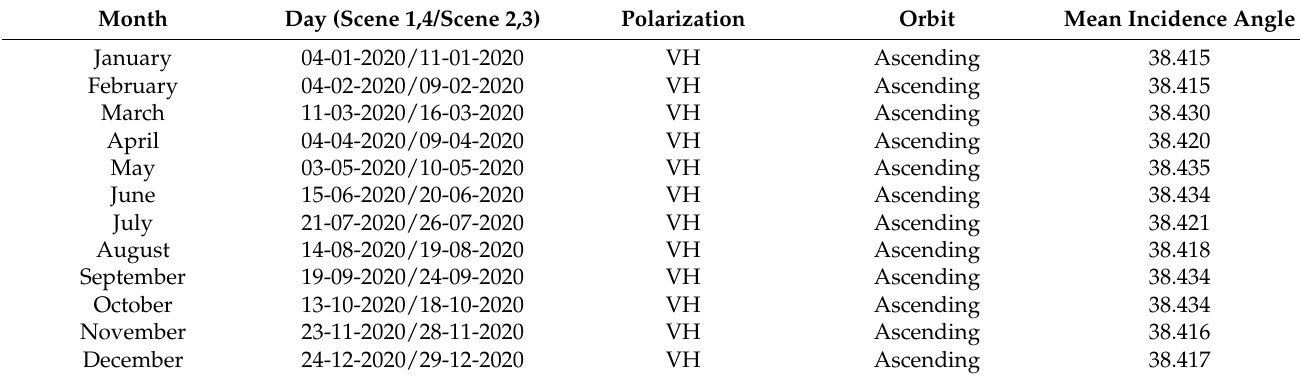
Table 1. The dates for radar image acquisitions.